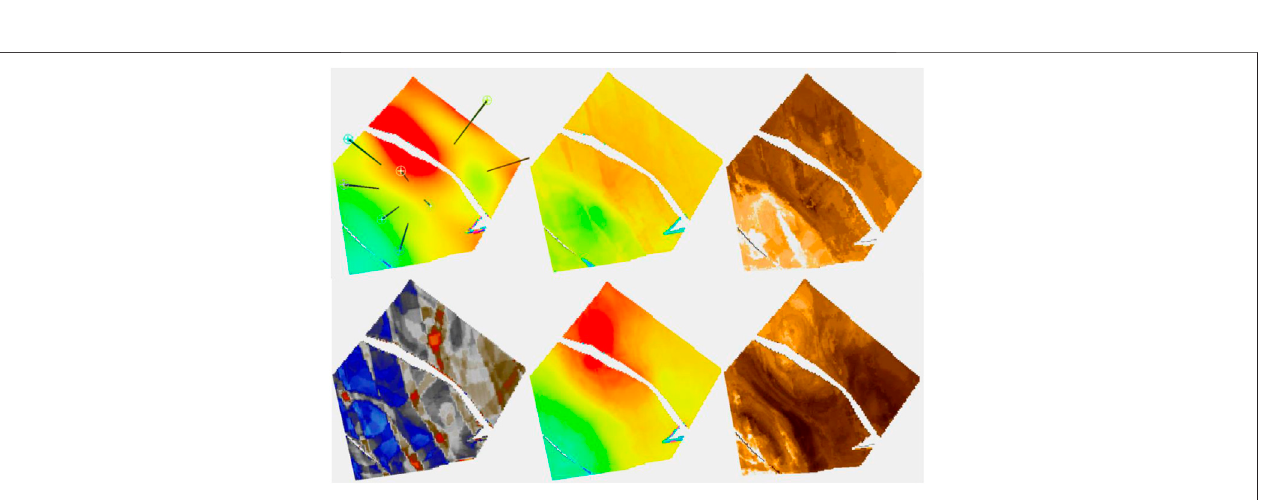
FIGURE 9 | Upper images are the eight-well case, while the lower ones are the 36-well case. On the left is Ember simulation, while on the right is the associated uncertainty.